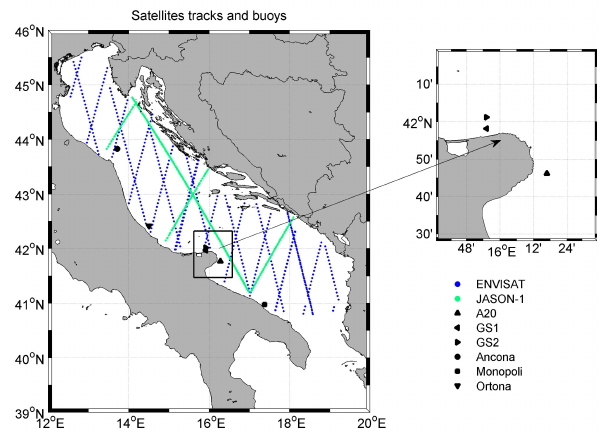
Fig. 1. Location of the buoys and satellite tracks available during the DART06